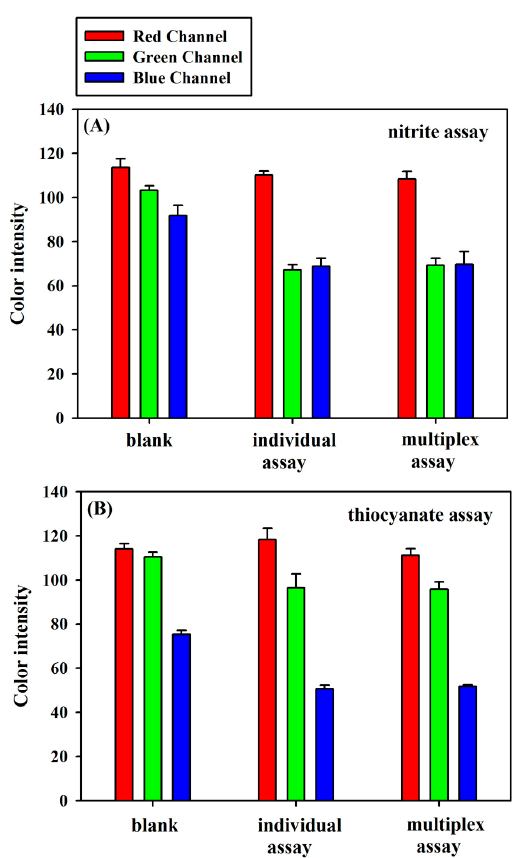
Figure 7. The RGB measurements for the individual assay and the multiplex assay: ( A ) 1 mM nitrite, ( B ) 2 mM